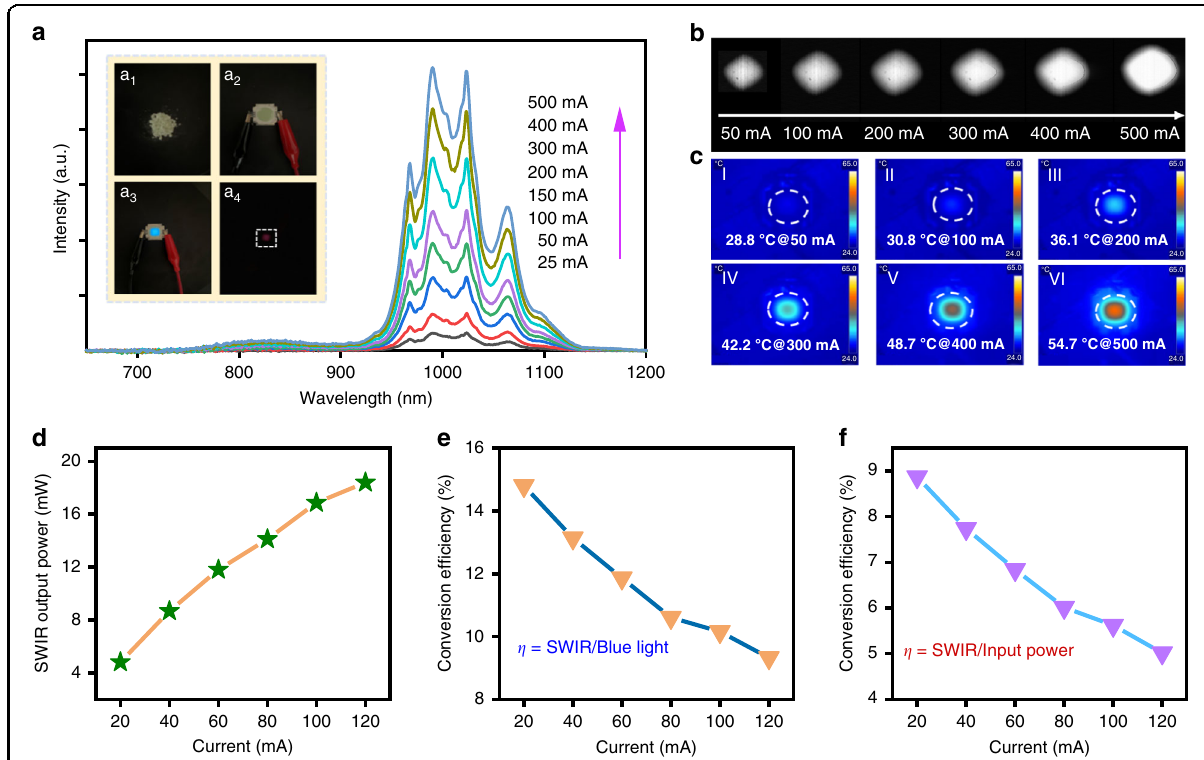
Fig. 5 Luminescence properties of phosphor-converted SWIR light sources. a Emission spectra of the SWIR LED through a combination of Lu 0.2 Sc 0.8 BO 3 :2%Cr 3 + ,5%Yb 3 + with blue LED at varied current over 25 – 500 mA. The upper insets show the as-synthesized phosphor powders (a 1 ), the constructed high-power SWIR LED prototype device (a 2 ), working SWIR LED taken by a standard digital camera in the absence (a 3 ) and presence (a 4 ) of a long-pass fi lter at 650 nm. b SWIR images of the prototype device at varied driving currents. c Thermal images and actual working temperatures of SWIR LED device at different input currents. d SWIR output power of the fabricated LED with varying the input current. e , f Blue-to-SWIR power conversion ef fi ciency (the ratio of SWIR radiant power to the output power of blue LED) and electricity-to-SWIR light energy conversion ef fi ciency (the ratio of SWIR radiant power to the input electrical power) of the SWIR LED as a function of the driving